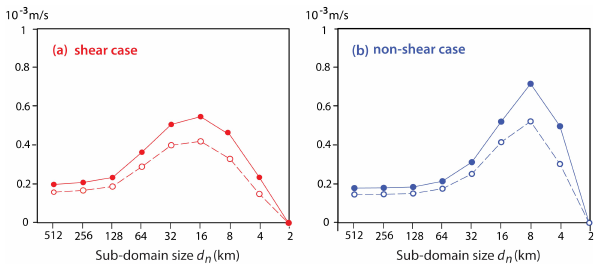
Fig. 10. Weighted ensemble average of the eddy transport of water vapor at 3km height. Open circles: estimated with the right hand side of Eq. (13). Closed circles: directly diagnosed with the left hand side of Eq.